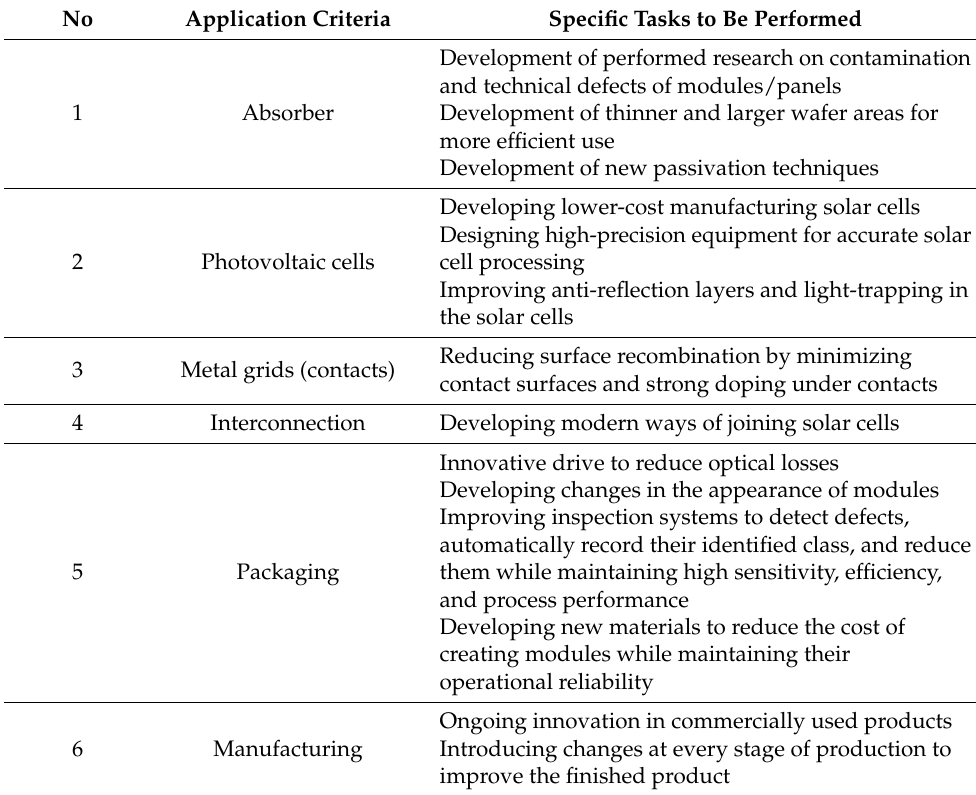
Table 1. Technology development in various areas of the photovoltaic industry